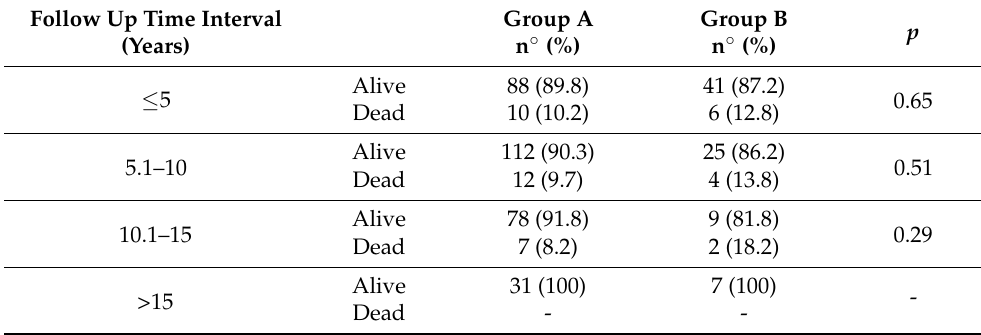
Table 4. Death rate in patients of group A and B, divided by 5 years interval of follow-up.